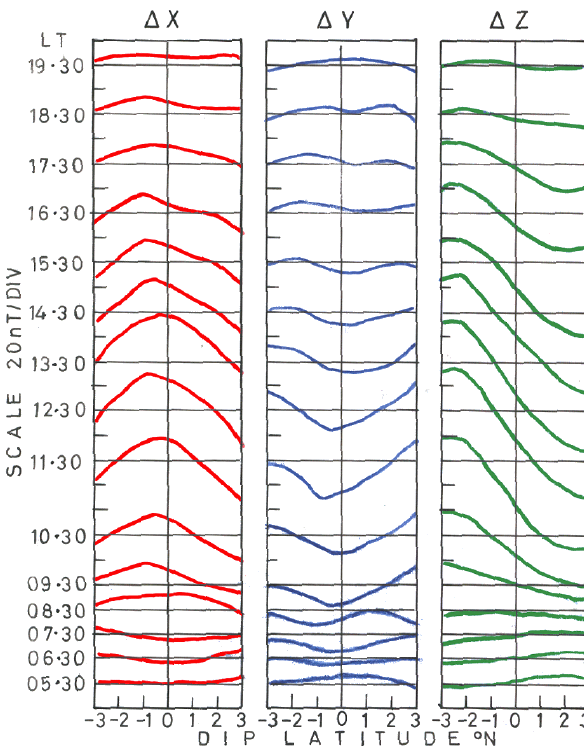
Fig. 12. Mean latitudinal profiles of the regular solar daily varia- tions of 1X , 1Y and 1Z at East Brazilian stations during Novem- ber 1990 to March 1991.